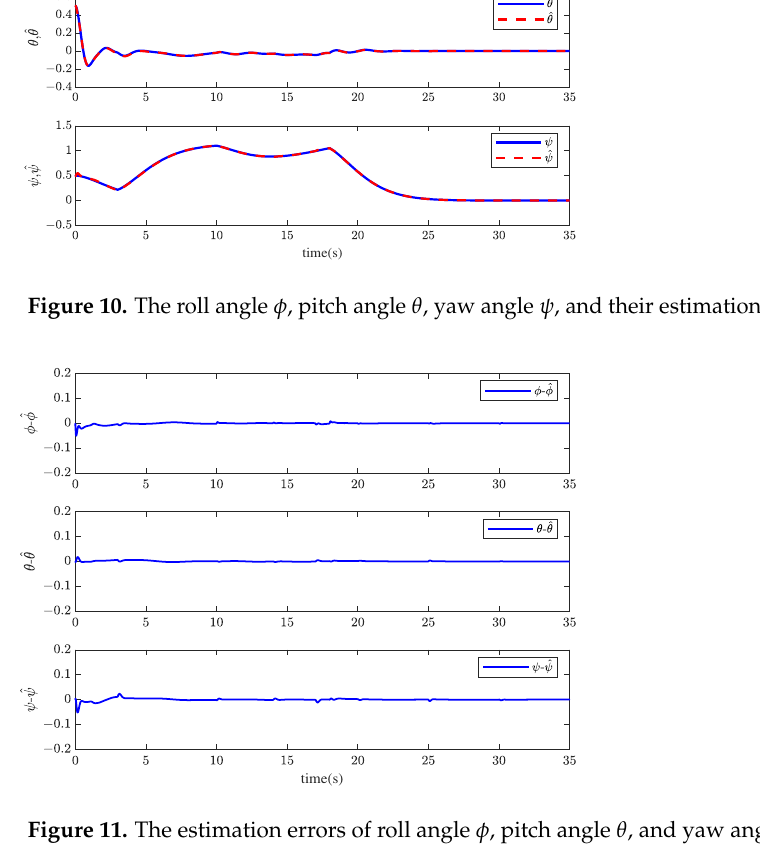
Figure 11. The estimation errors of roll angle φ , pitch angle θ , and yaw angle ψ when z = 1